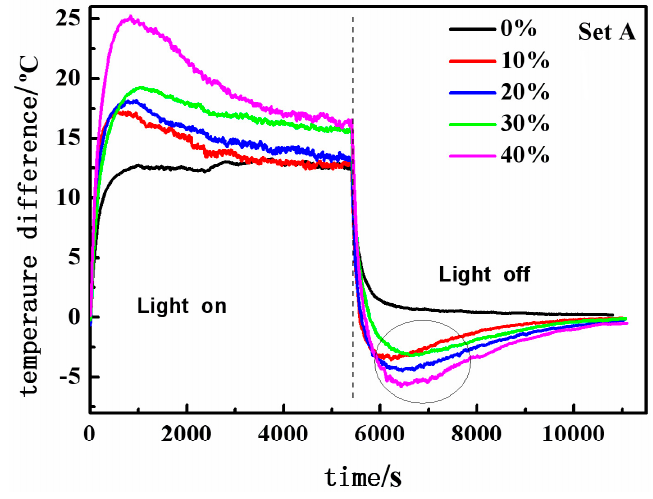
Figure 7. Variations of the temperature differences with time for the five test rooms that consist of six identical boards containing 0, 4, 8, 12 and 16 wt % of RT28, respectively (Set